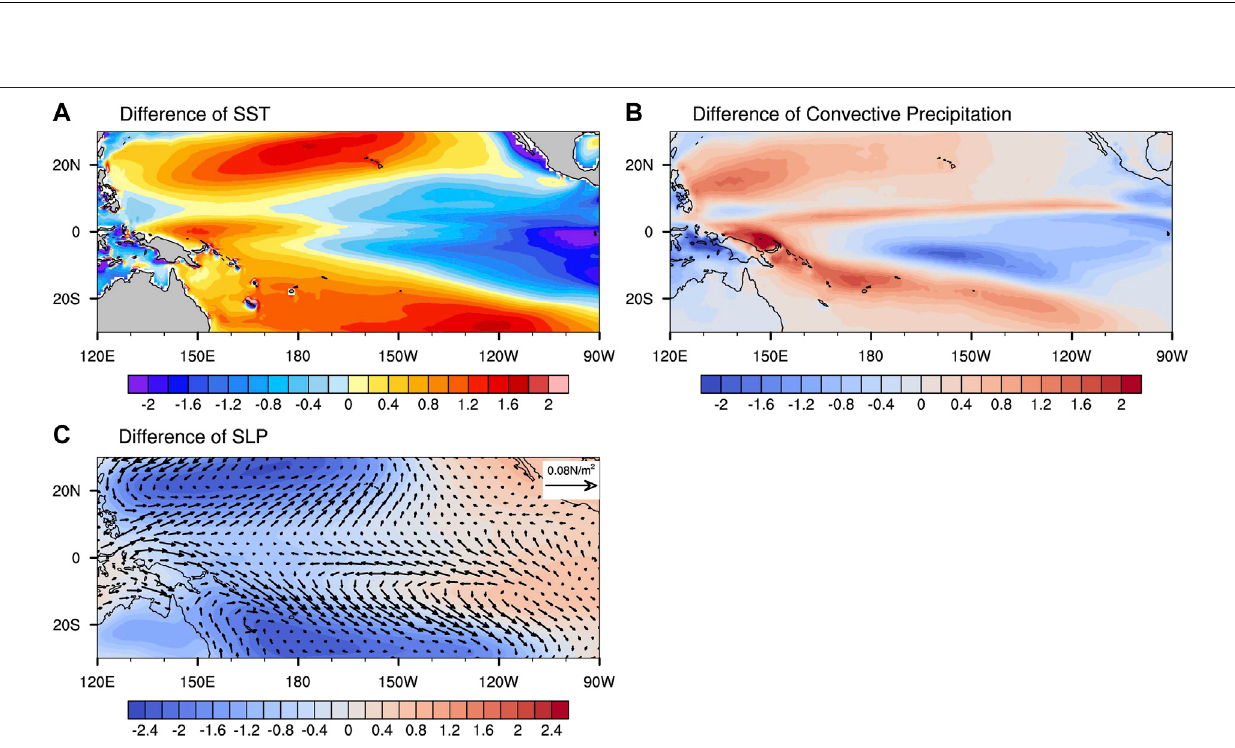
Frontiers in Earth Science |